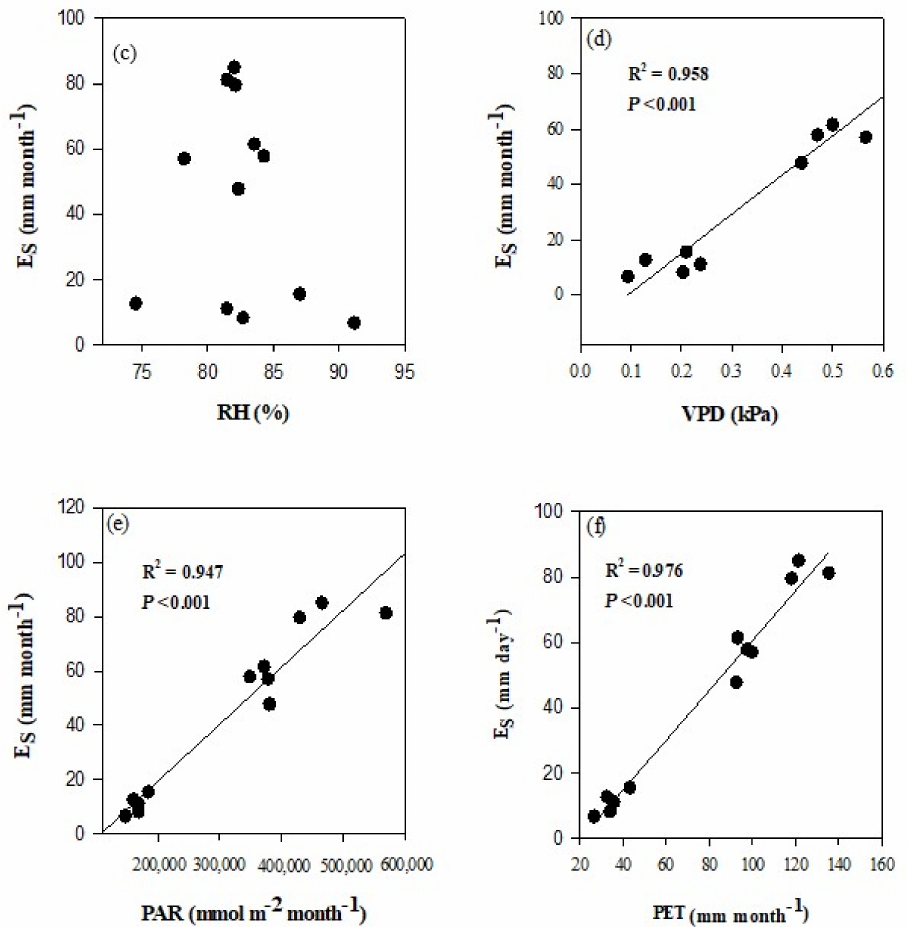
Figure 9. The relationships between monthly stand transpiration ( E s ) (mm) and ( a ) rainfall (mm); ( b ) air temperature (T a ) ( ◦ C); ( c ) photosynthetically-active radiation (PAR) (mmol m − 2 month − 1 ); ( d ) air relative humidity (RH) (%); and ( e ) vapor pressure deficit (VPD) (Kpa); and ( f ) potential evapotranspiration (PET) (mm) during the study